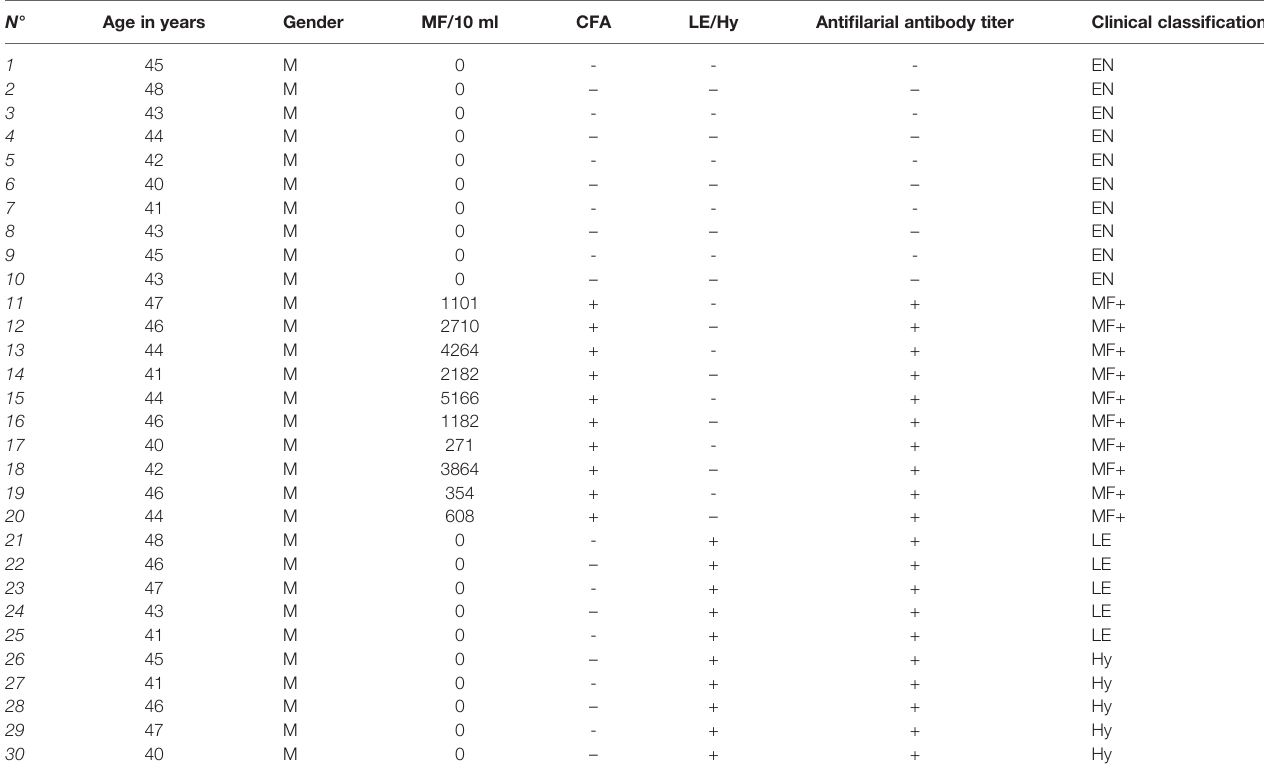
TABLE 1 | Clinical characteristics of patients and controls.